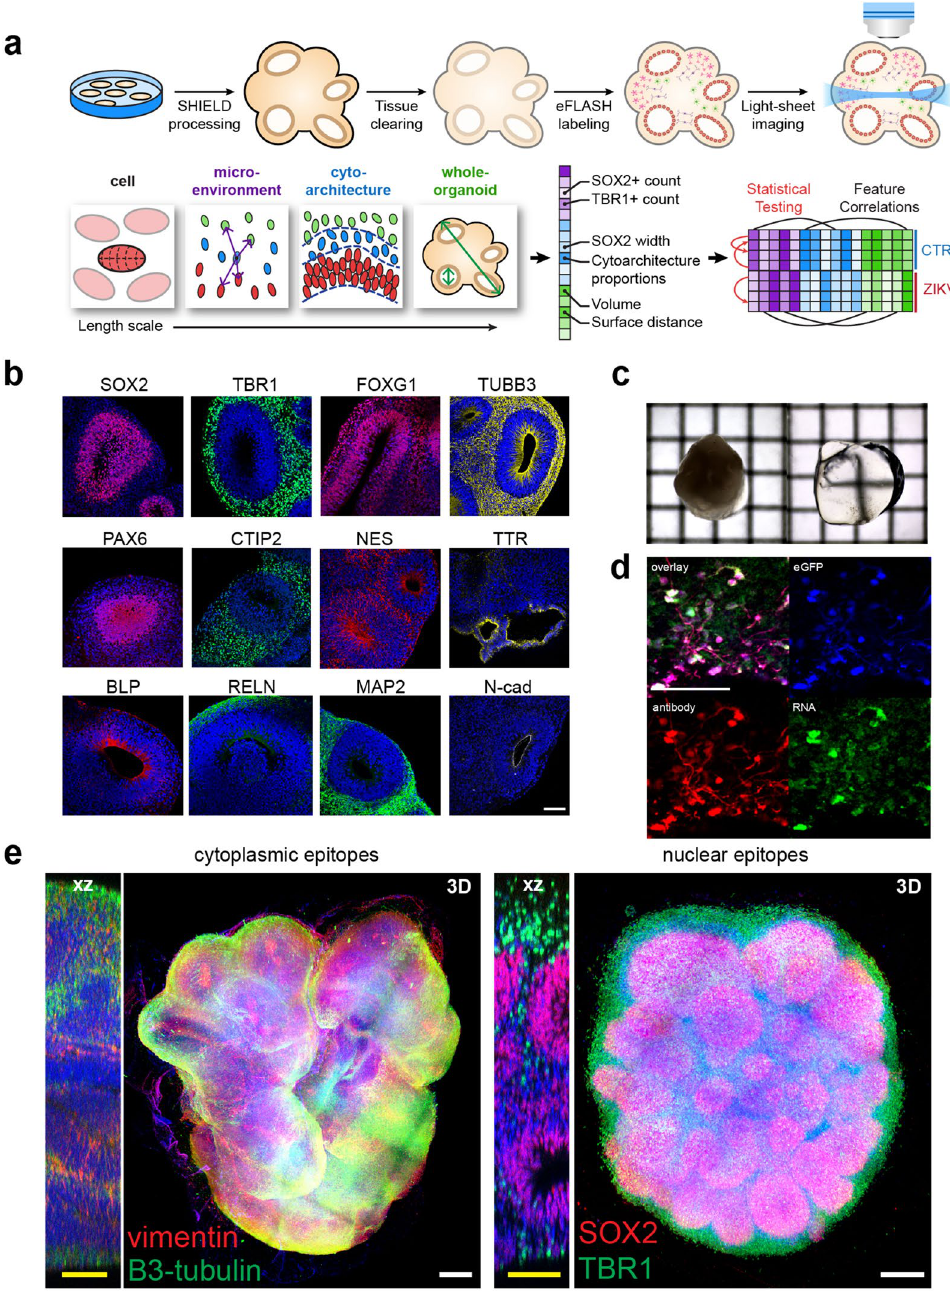
Figure 1. Pipeline for multiscale hyperdimensional analysis of organoids. ( a ) Scheme showing the pipeline where cerebral organoids are grown from stem cells, fixed in 4% PFA, then post-fixed with SHIELD poly- epoxide crosslinker. Organoids are then delipidated and labeled with antibodies using eFLASH for rapid uniform staining. An axially sweeping light-sheet microscope was used for rapid (15 min per organoid) imaging of cleared intact organoids at 0.65 × 0.65 × 2.0 µm voxel resolution. Quantitative analysis applies automated algorithms and convolutional neural networks to measure multiscale features. We applied this pipeline for unbiased high-dimensional phenotyping of different experimental models. ( b ) SHIELD is compatible with many common markers for cerebral organoids. Data show antibody staining of SHIELD-cleared day 45 organoids using antibodies listed in Supplementary Table 1. ( c ) After delipidation and immersion in refractive index matching solution (dPROTOS), organoids are optically transparent and can be imaged with standard confocal microscopy. Grid = 1 mm. ( d ) SHIELD preserves endogenous fluorescence, mRNA and protein epitopes. Images show an organoid section containing GFP-labeled cells co-stained with anti-GFP antibody and a GFP mRNA FISH probe ( e ) A 3D render of day 35 cerebral organoid stained using Syto16 (nuclear dye, blue), β3-tubulin (neuronal marker, green) and vimentin (glial marker, red) or Syto16 (nuclear dye, blue); TBR1 (postmitotic neuron, green); SOX2 (progenitor cells, red). Images show a 3D render and a 2D view of the XZ plane to show whole-tissue labeling. Scale bars (yellow, 100 µm; white, 200